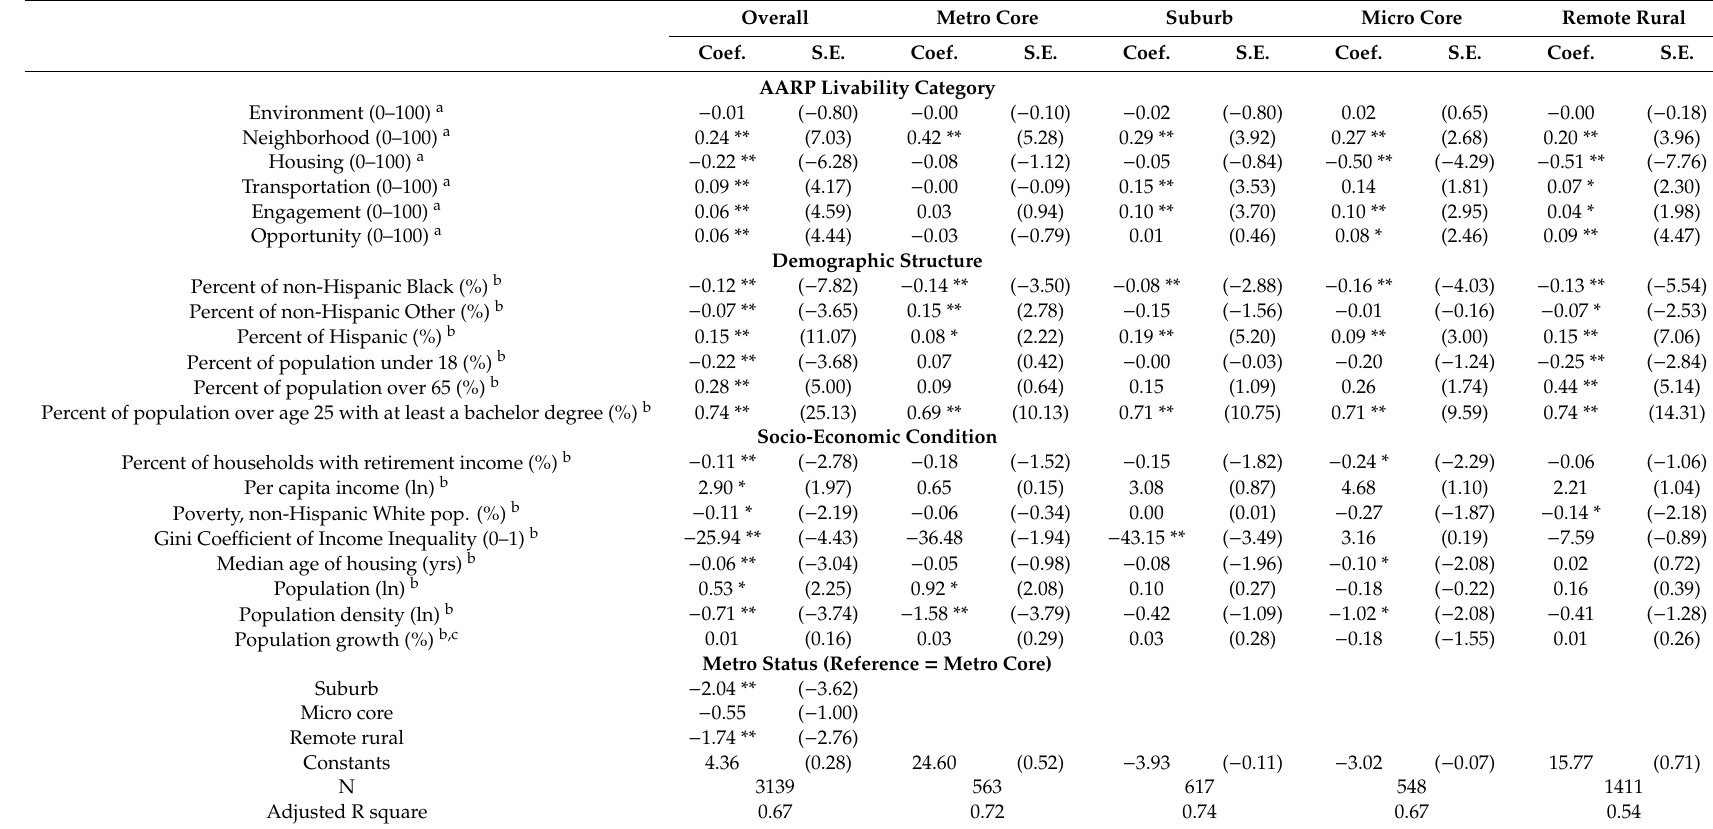
Table 2. Di ff erentiating Community Health by Metro Status and Livability Categories: OLS model results (US counties). Overall Metro